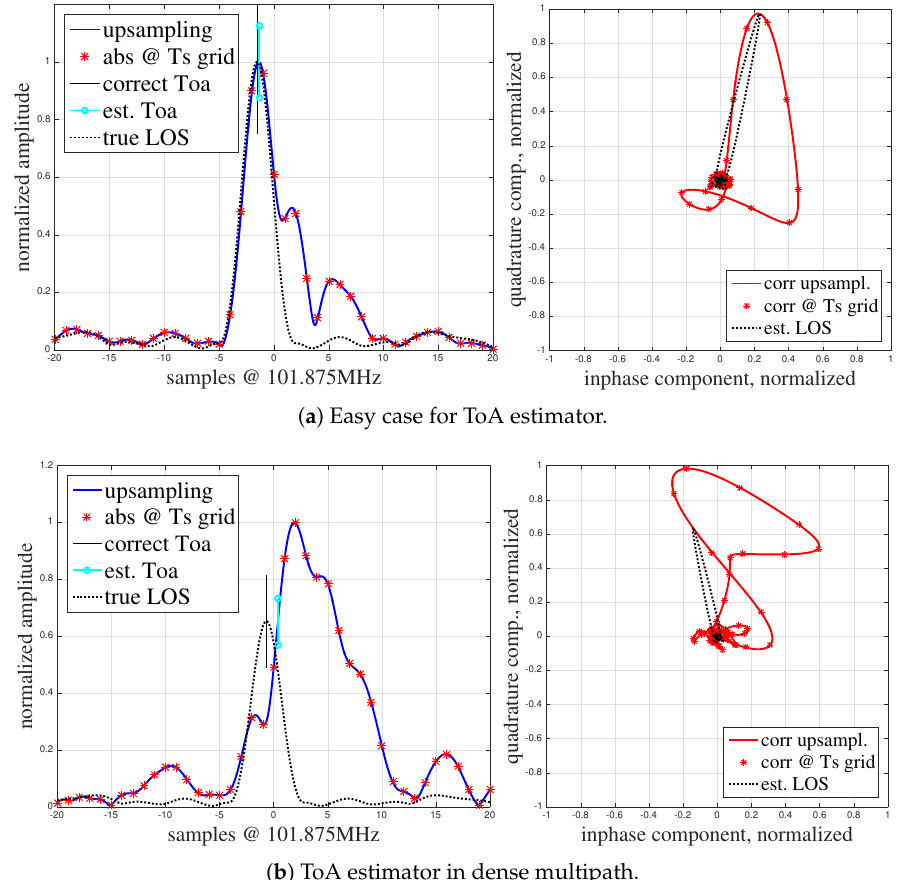
Figure 2. Examples for disturbed correlation functions. ( a ) A part of the signals arrive at a significant delay but the ToA estimator is still able to find the close-to-optimal ToA estimate. ( b ) ToA estimation in dense multipath (higher